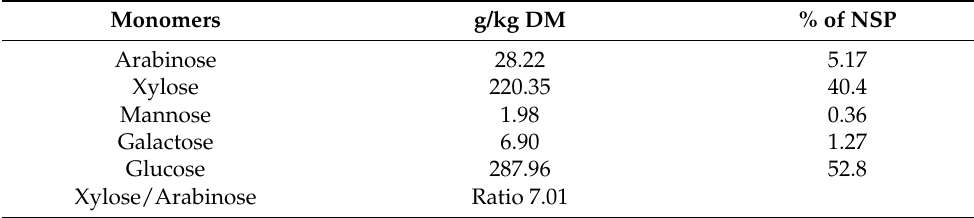
Table 4. Content and proportion of polysaccharide monomers in untreated wheat straw.